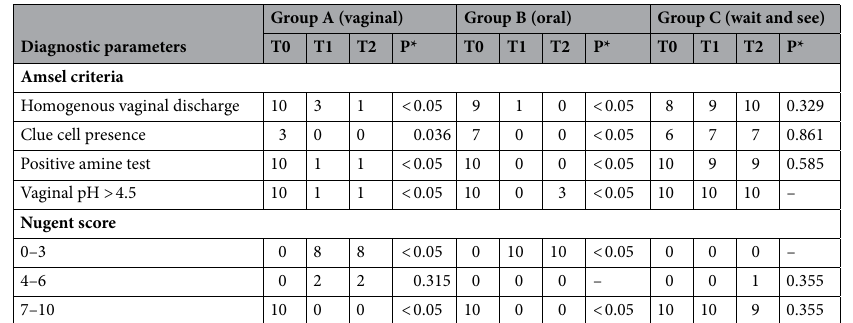
Table 5. Clinical criteria evaluation for each treatment group (A: vaginal administration, B: oral administration; C: wait and see) at baseline (T0), 10 days after the start of the treatment (T1) and 30 days after the end of the treatment (T2). *Statistical significance P < 0.05; P refers to all pairwise comparisons.